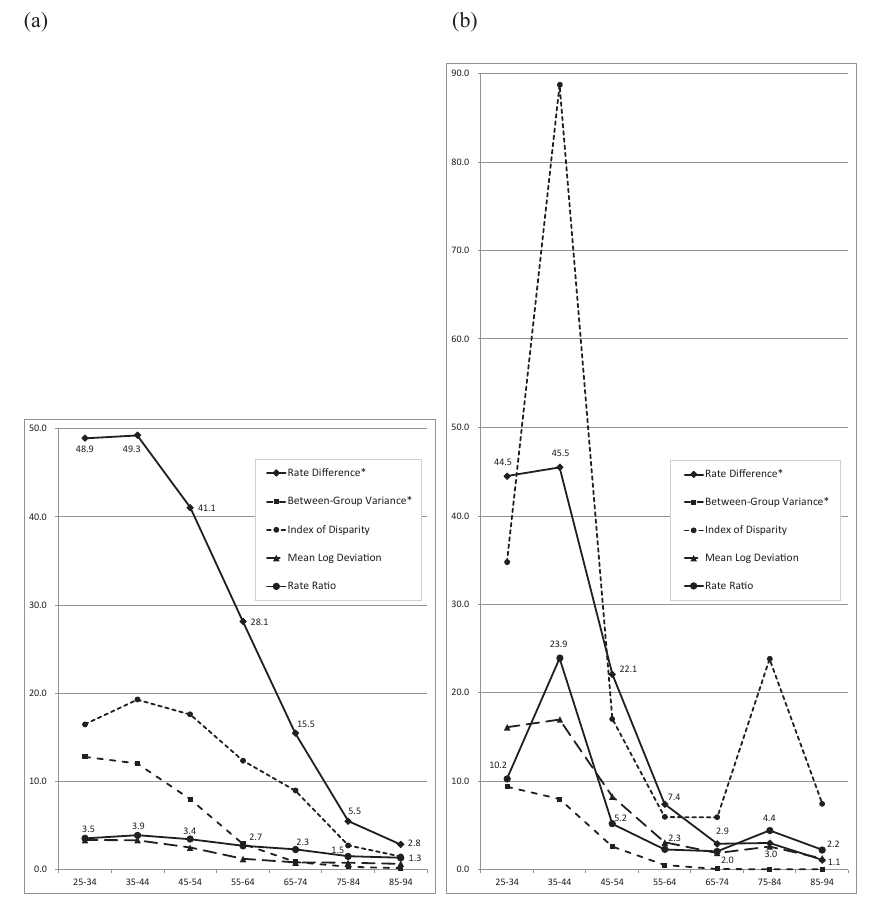
Fig. 1. Sex- and age-speci fi c estimates of inequality indicators for educational inequality in current smoking: (a) men and (b)